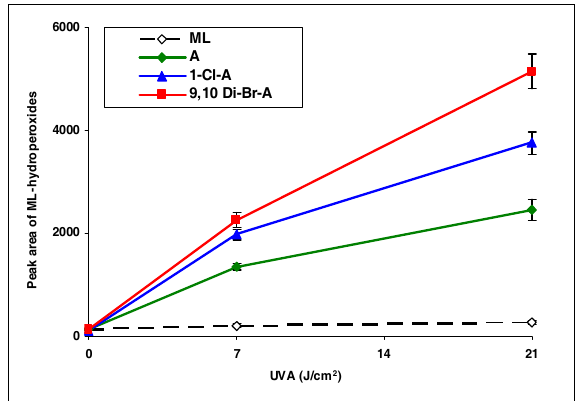
Figure 2: Peroxidation of methyl linoleate initiated by anthracene, 1-Cl-anthracene and 9,10-DiBr-anthracene with, 0, 7, and 21 J/cm2 of UVA light.